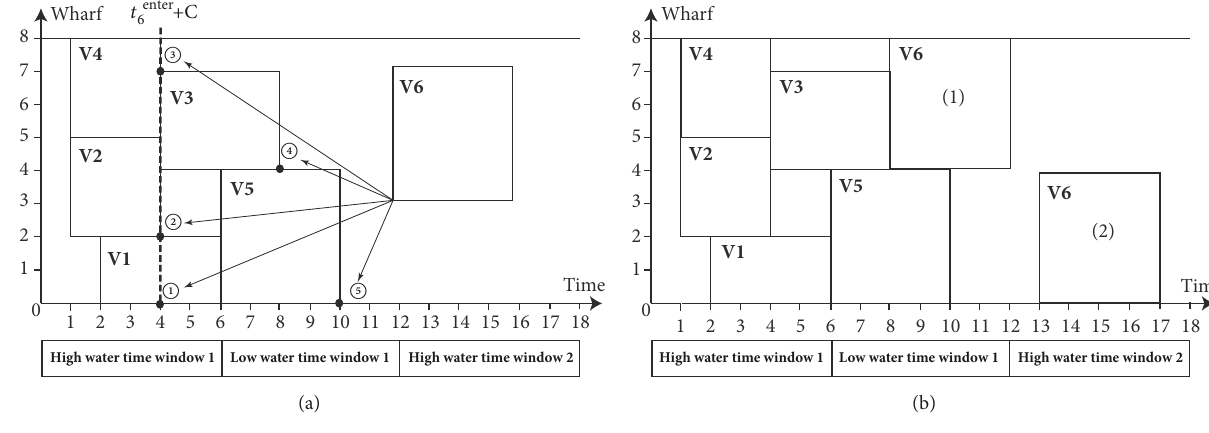
Figure 4: Illustration of possible locations for processing vessel 𝑉 6 .